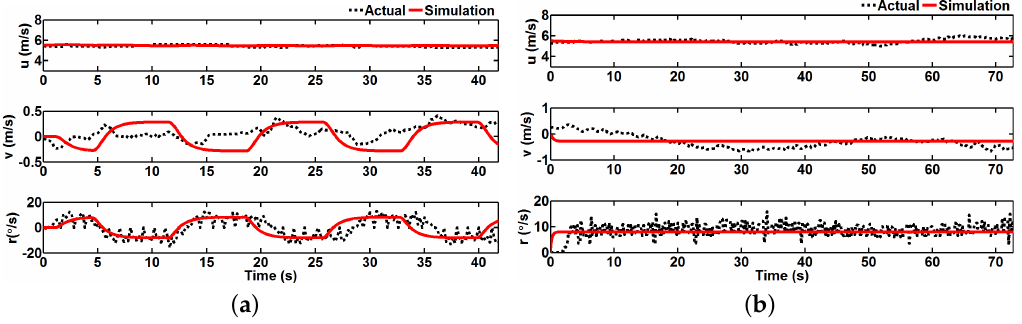
Figure 5. The comparison results about the state quantities of vessel. ( a ) 10 ◦ /10 ◦ zig-zag test; ( b ) 10 ◦ turning test.